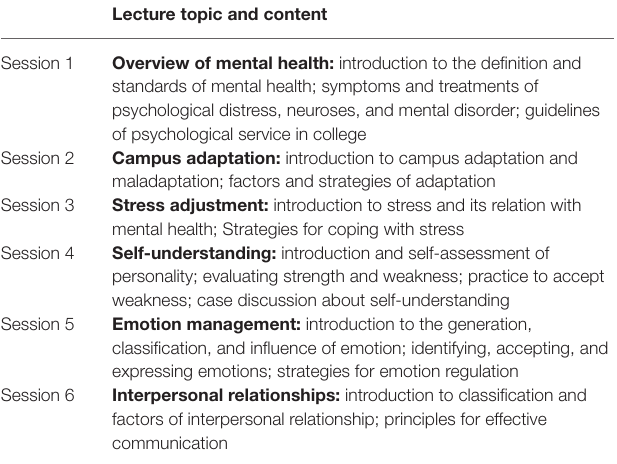
TABLE 2 | Description of the psychoeducational lectures.